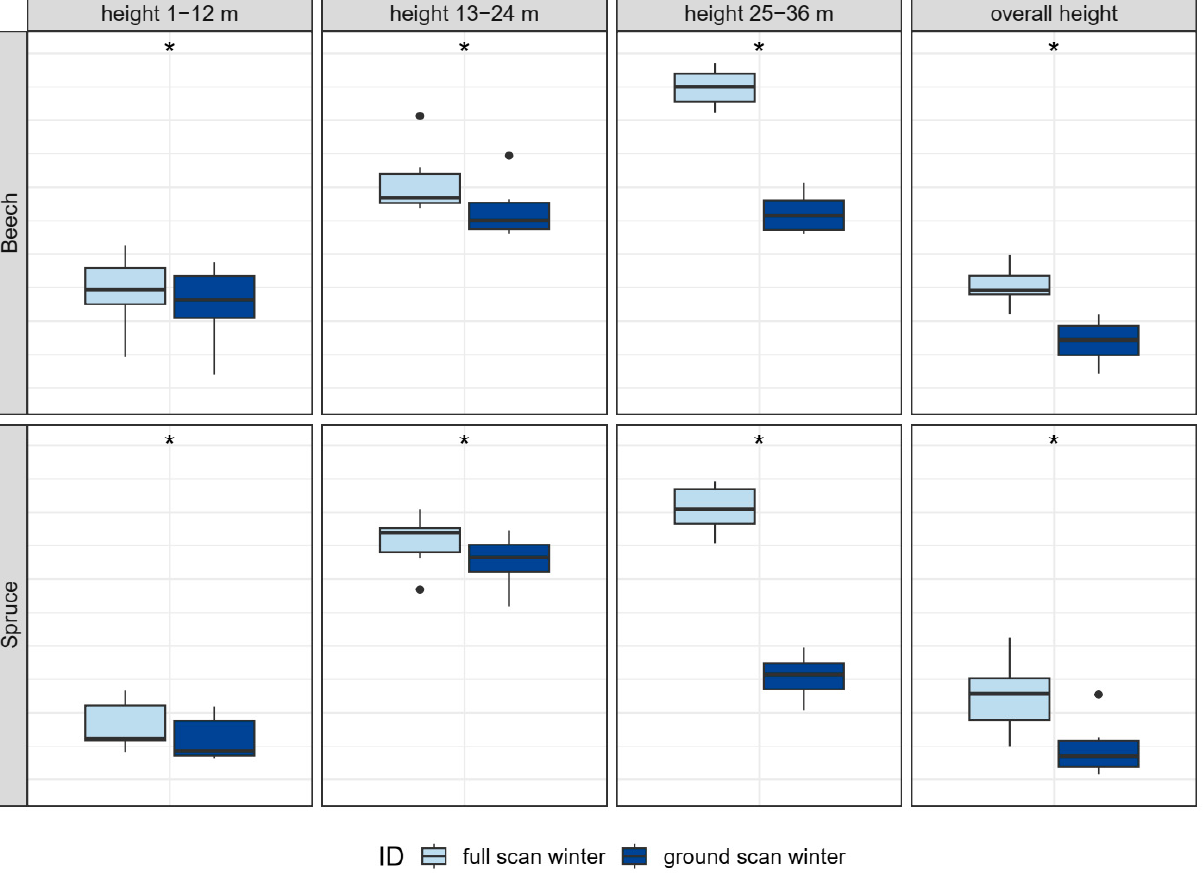
Figure 7. Methodological comparison of different point cloud sections for the beech and spruce stands between the ground scans and full scans conducted in winter. The boxplots are based on six circular subplots, each with a radius of 5 m. Shown are the box dimensions for point cloud sections of 1–12 m, 13–24 m and 25–36 m and the total point cloud. Asterisks indicate significant differences between the scans (*: p ≤ 0.05). The resolution of the point cloud was 5 cm.